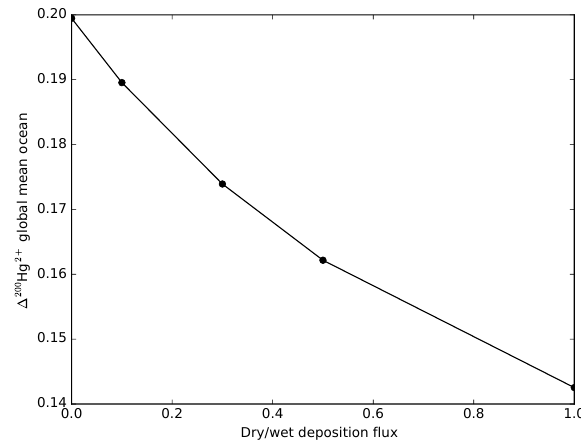
Figure 14. Profiles of (cid:49) 199 Hg of MMHg and Hg(II) for photo- chemical fractionation mechanisms. Panel (a) are observations of MMHg (cid:49) 199 Hg inferred from measurements of fish (Blum et al., 2013), and (cid:49) 199Hg for Hg(II) from measurements of Hg on parti- cles (Motta et al., 2018 #6704). Panel (b) shows model results with MMHg photoreduction, using isotope fractionation from Bergquist and Blum (2007). Panel (c) shows the impact of Hg(II) photore- duction (Kritee et al., 2007). Panel (d) shows sum of MMHg and Hg(II) photoreduction mechanisms. Locations for the Eq. Pac. and Olig. Atl. profiles are given in Fig. 4.